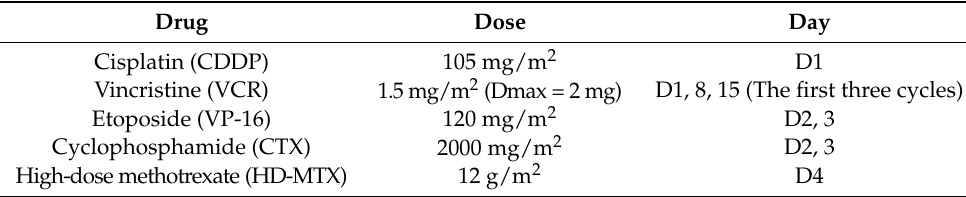
Table 1. The detailed information for the CHEMO